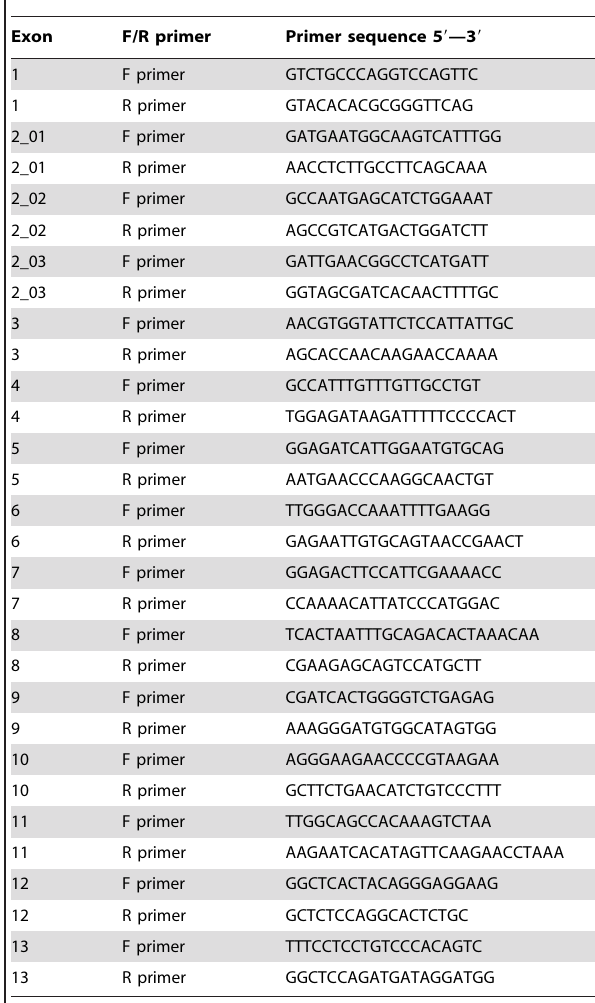
Table 1. Primers used to sequence the 13 exons of TRPC6 .